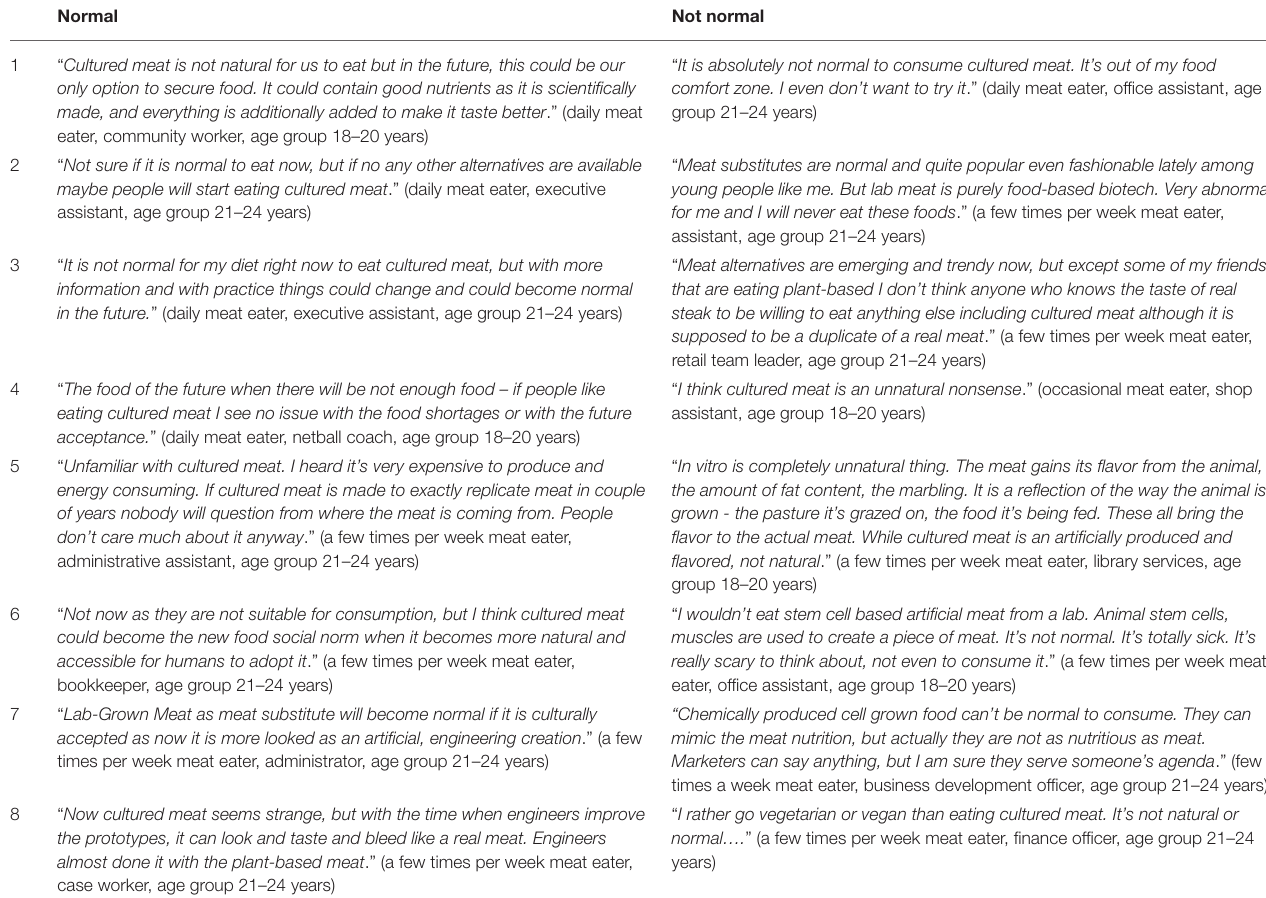
TABLE 11 | Sydney Gen Z’s perceptions about cultured meat being normal/not normal in the future. Normal Not normal